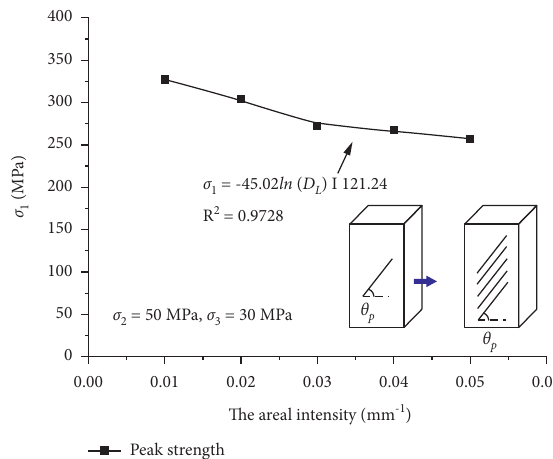
Figure 13: Effect of the areal intensity on the strength of specimens containing multiple parallel cracks.